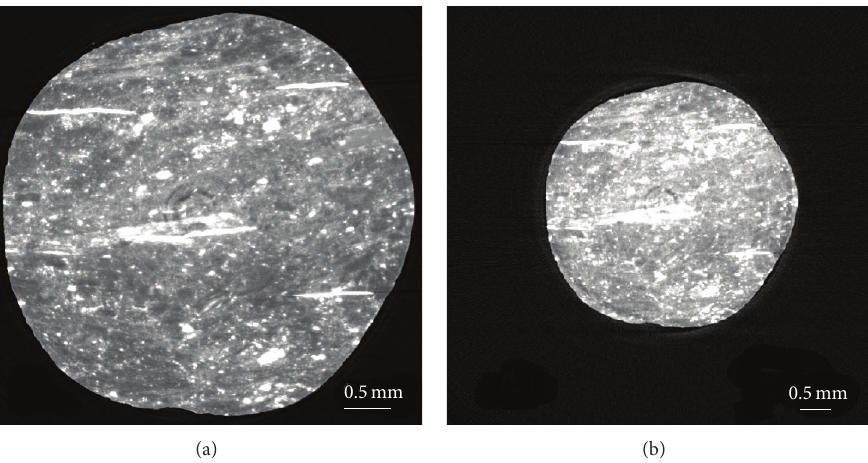
Figure 2: The original reconstructed CT slices at different spatial resolutions: (a) at resolution of 3.7 𝜇 m; (b) at resolution of 11.84 𝜇 m.